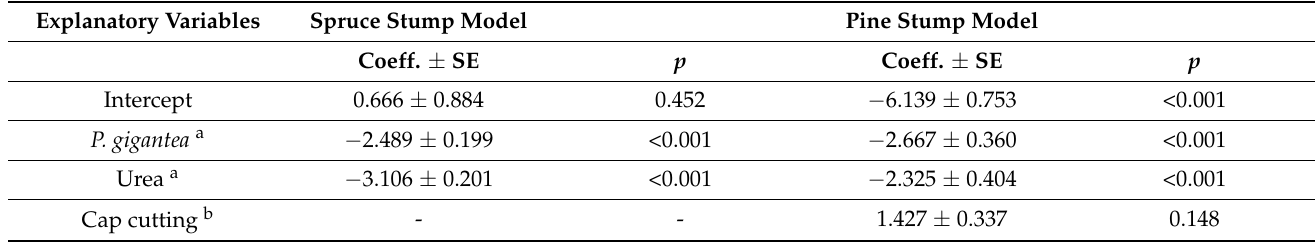
Table 3. The effects of treatment ( P. gigantea or urea), harvesting method (clearcutting, cap cutting or thinning), stump diameter (cm), wood moisture (%), and peat thickness (cm) on the infected area by Heterobasidion (%) on cut stumps. Coefficients and standard errors of means (SE) have been presented for linear mixed models. Negative effects on the response, i.e., the infected area by Heterobasidion (%), are indicated as negative and positive ones as positive coefficients. Models are presented separately for Norway spruce ( n = 535) and Scots pine stump surfaces ( n = 351). Values in the table are in logit scale since the response was logit transformed when the models were estimated. p -values < 0.05 are in